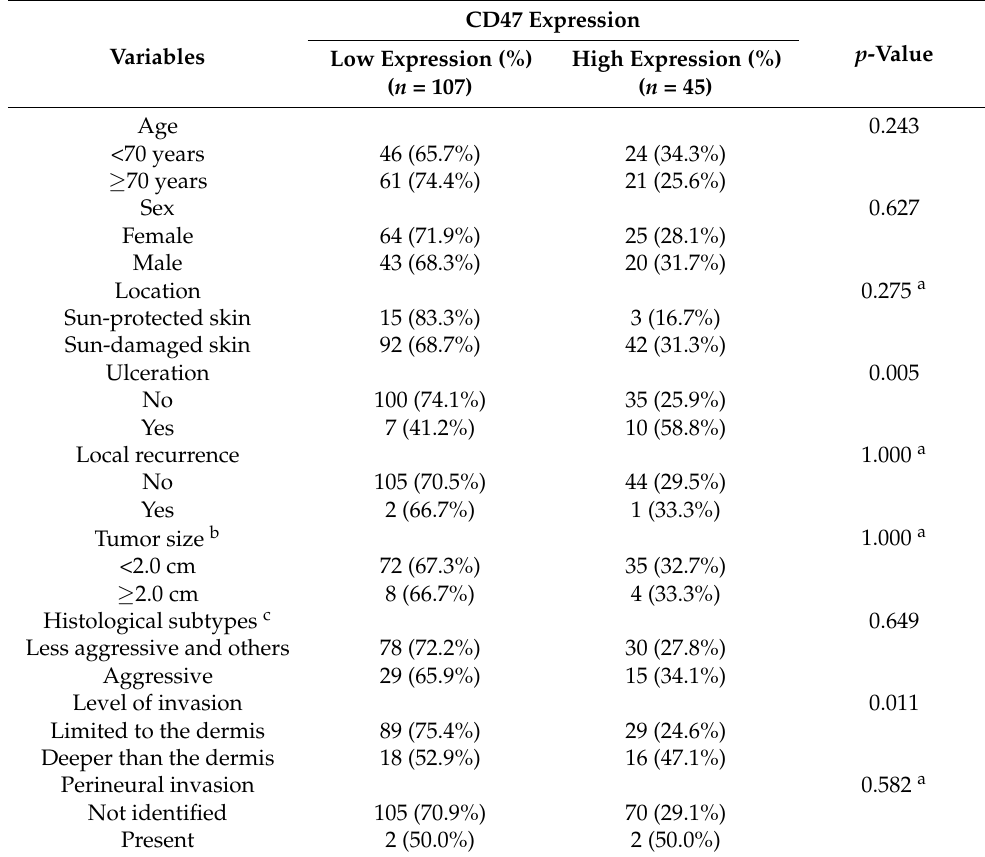
Table 1. Correlations between CD47 expression and clinicopathological characteristics in cases with basal cell carcinoma ( n =